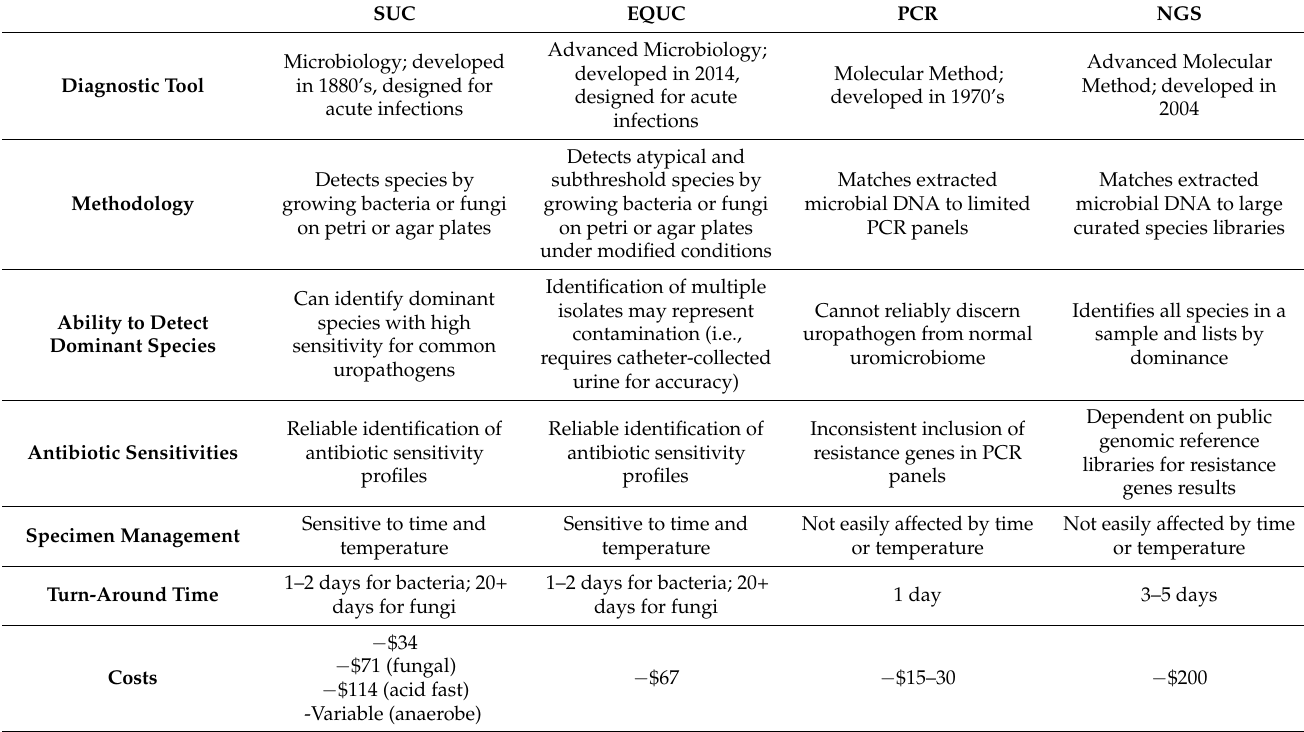
Table 1. Comparison of Different Diagnostic Methods of Urinary Tract